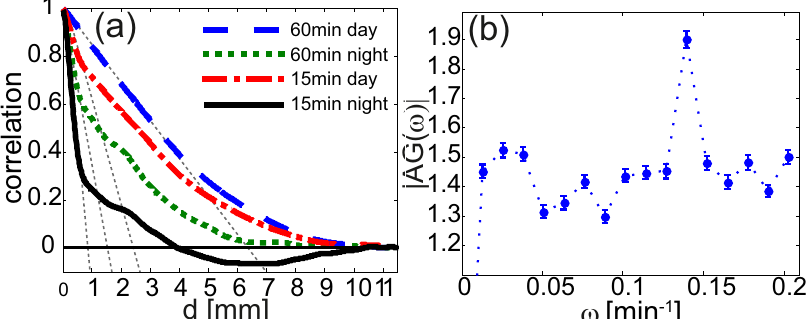
Fig. 3 Characteristic scales of the area-growth fi eld. a Spatial correlation between area-growth ( AG ) values as a function of the distance between them, d . Different line styles and colors represent different time samples (see legend). Measurements were taken as the leaf grew from 6 to 13 mm in length. Dotted lines are linear extrapolations of the data from 0 to 1 mm. b Mean Fourier transform in time over 1200 signals AG ð t Þ , taken during light-time intervals of 1 day (8 h). ω is the temporal frequency. The signal AG ð t Þ is taken in Lagrangian coordinates. The plot does not include the long, dominant, time scale of 24 h (Supplementary Fig.